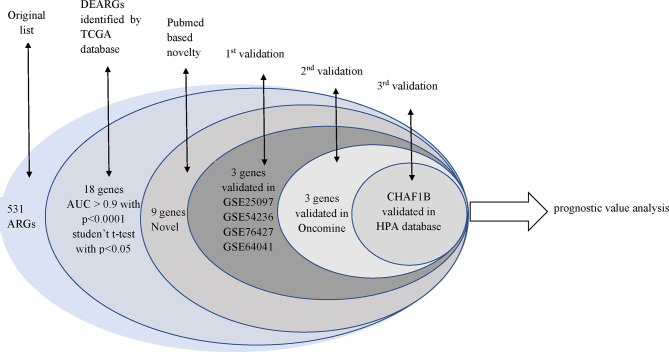
The flowchart of this study.